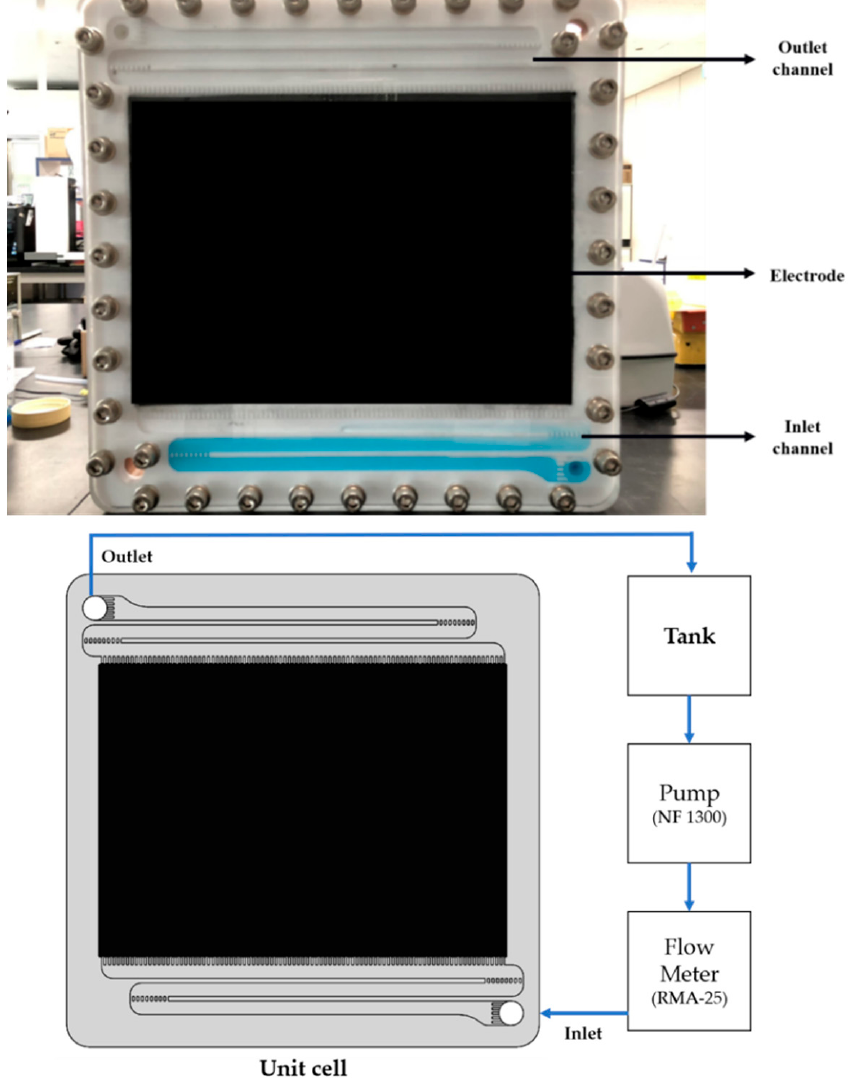
Figure 6. Setup of flow visualization experiment.